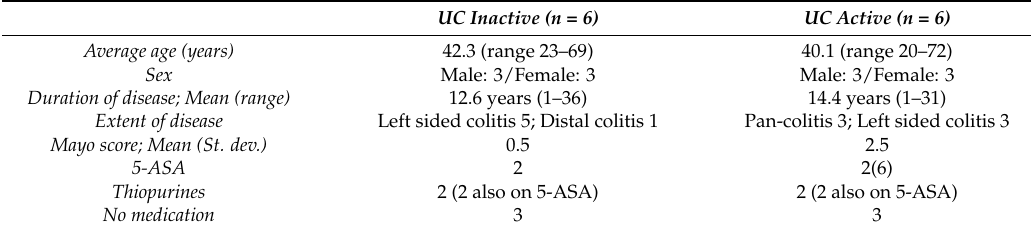
Table 2. Demographic data of patients analysed by Western blot. n: number of subjects; St. dev.: standard deviation; 5-aminosalicylic acid: 5-ASA.